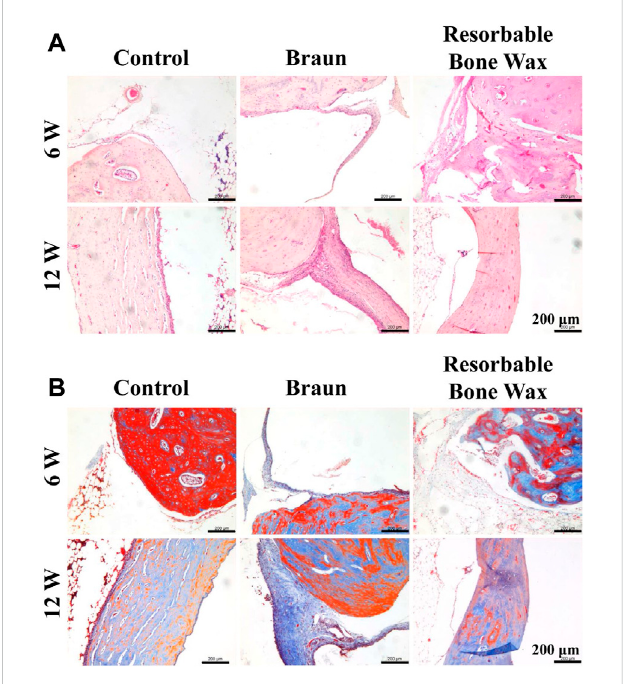
FIGURE 5 Histological staining of tibia. (A, B) H&E (A) and Masson (B) staining images at defect sites 6 and 12 weeks post-surgery.